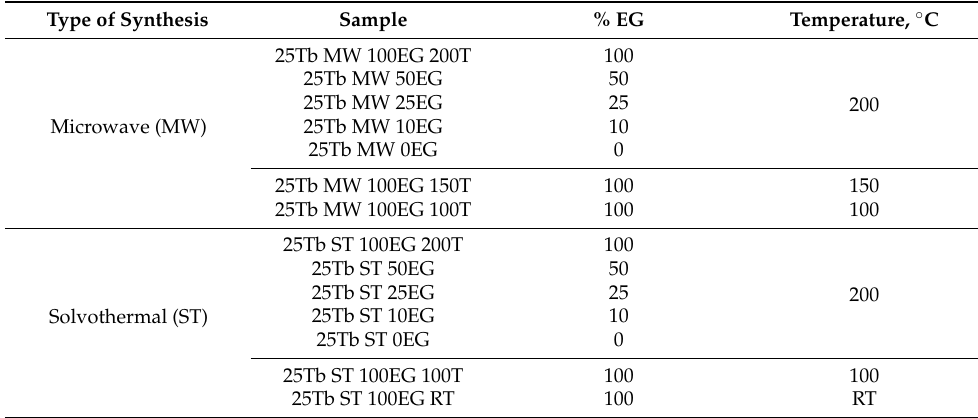
Table 2. The synthesis